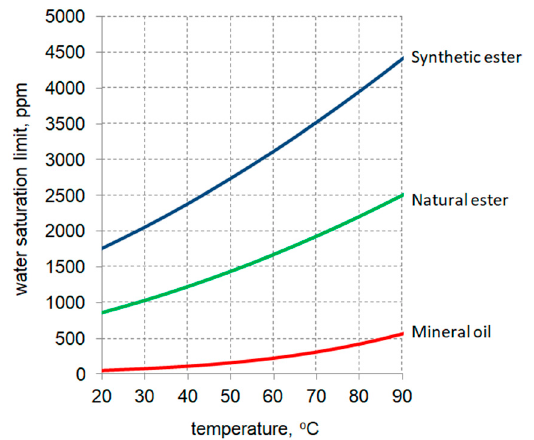
Figure 2. Comparison of the water saturation limit of four selected insulating liquids, on the basis of data from [9].